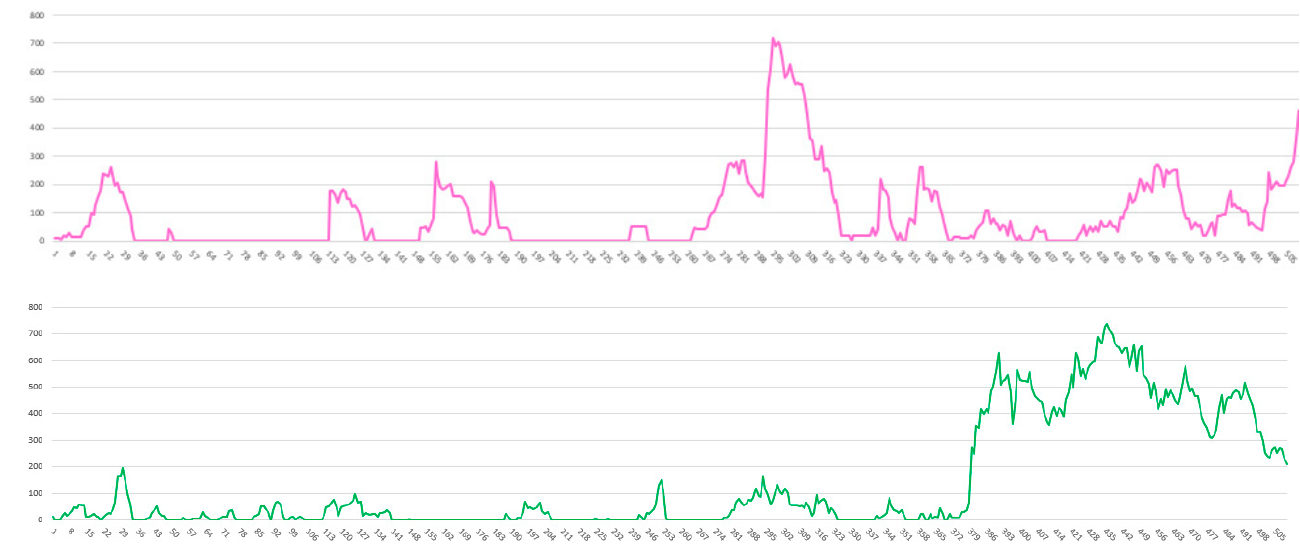
Figure 12. Geovisualization graph showing the landmark category type (pink, top ) and the green objects category type (green, bottom ) visible from the tourism route of case study 2.